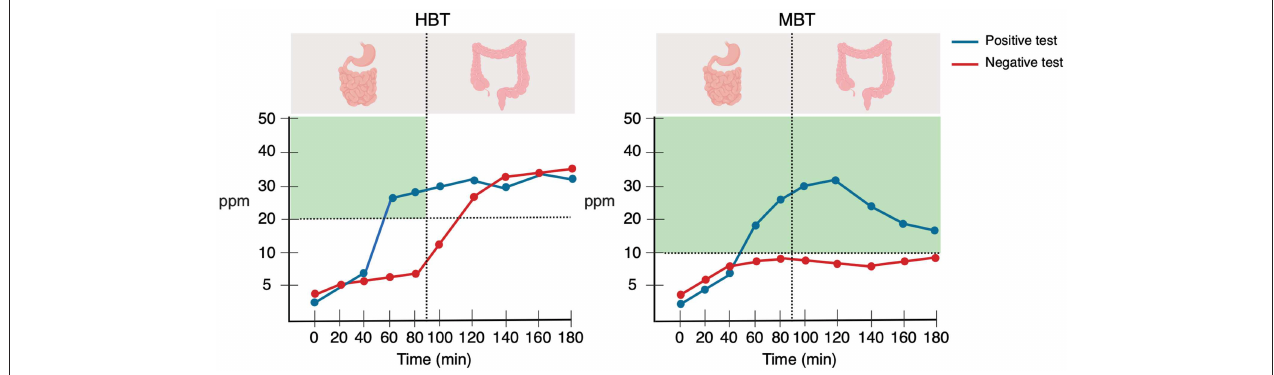
FIGURE 4 | Graphical representation of the hydrogen and methane breath tests. The vertical dotted line indicates the completion of the orocecal transit time, and the horizontal dotted line indicates the current diagnostic thresholds for SIBO. The green shaded areas indicate where the test is considered positive. Created with